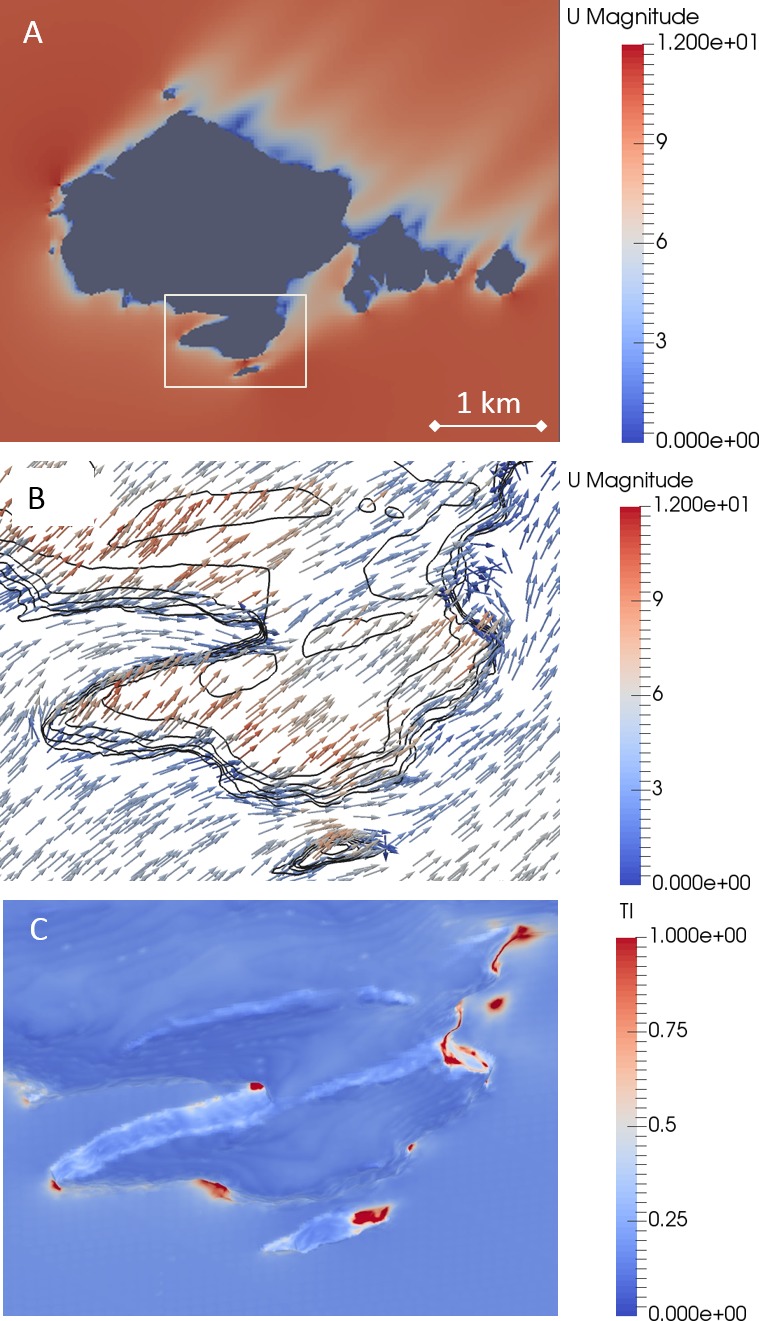
Airflows around Skomer Island (51.73611°N 5.29628°W), modelled with a SW wind.(A) A horizontal cross section of wind speed (m s−1) at 10 m above sea level (which intersects the island, given in grey) shows the reduction in wind strength near the cliffs (see supplement 1). (B) The horizontal wind vectors within the inset in A, modelled at 2 m normal to the surface, and coloured according to the total wind speed (m s−1). Wind is funnelled into the canyon on the left of the image (the Wick colony is located along the South side of this canyon), forcing birds to enter this area with a tailwind. (C) The turbulence intensity, TI, (a dimensionless ratio of the RMS of the turbulent wind fluctuations to the mean wind) at a distance of 2 m normal to the surface, within the inset shown in A. Typical values are ~0.1, so values of ~1 (red areas), indicate highly variable winds. Note these high values occur in areas with low mean winds (blue colours in B), so actual gust strength is low.